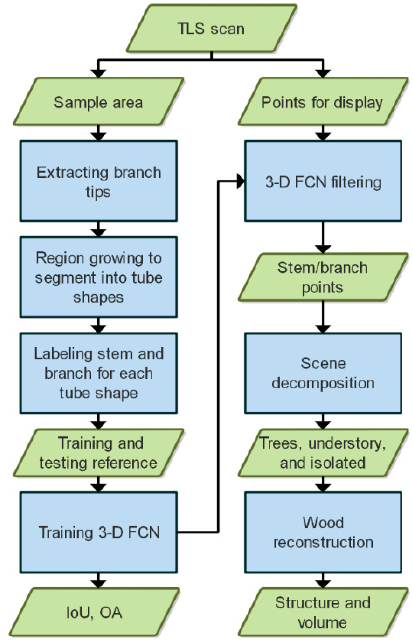
Figure 1. A framework of wood filtering and reconstruction from terrestrial laser scanning (TLS) plot scans. IoU stands for intersection over union and OA stands for overall accuracy.